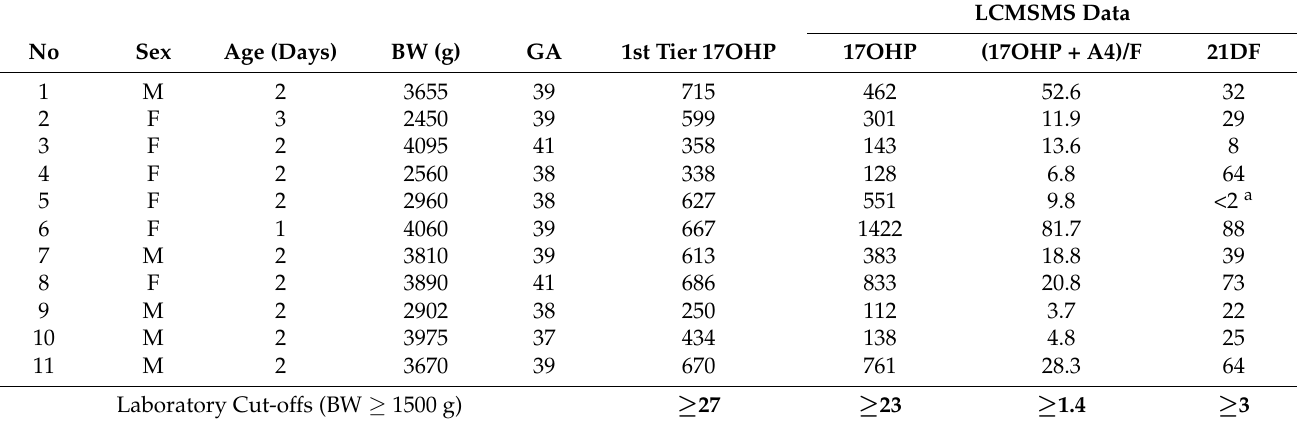
Table 1. NBS Laboratory Data for 11 confirmed CAH cases 2018–2021. All steroid data is nmol/L blood. All newborn screening results were positive for protocol 1 and protocol